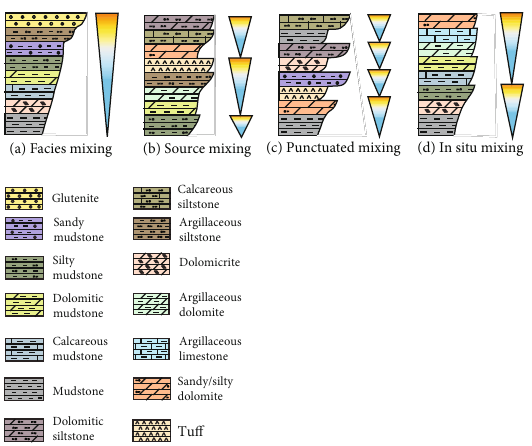
Figure 13: Main mixing processes and lithofacies associations of the Lucaogou Formation, Jimusar